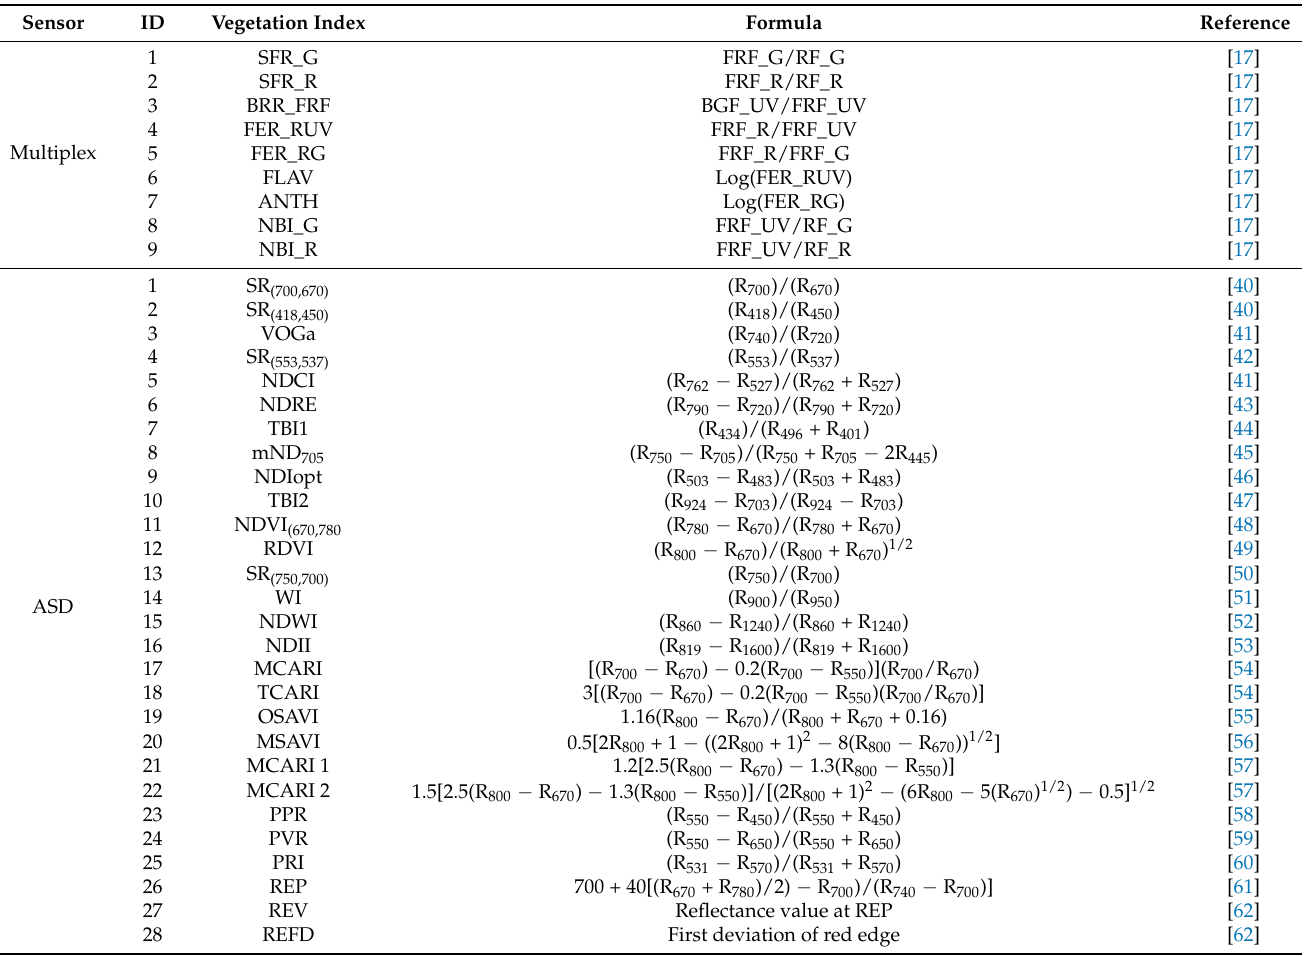
Table 3. Vegetation indices based on Multiplex 3 and ASD sensors used in this